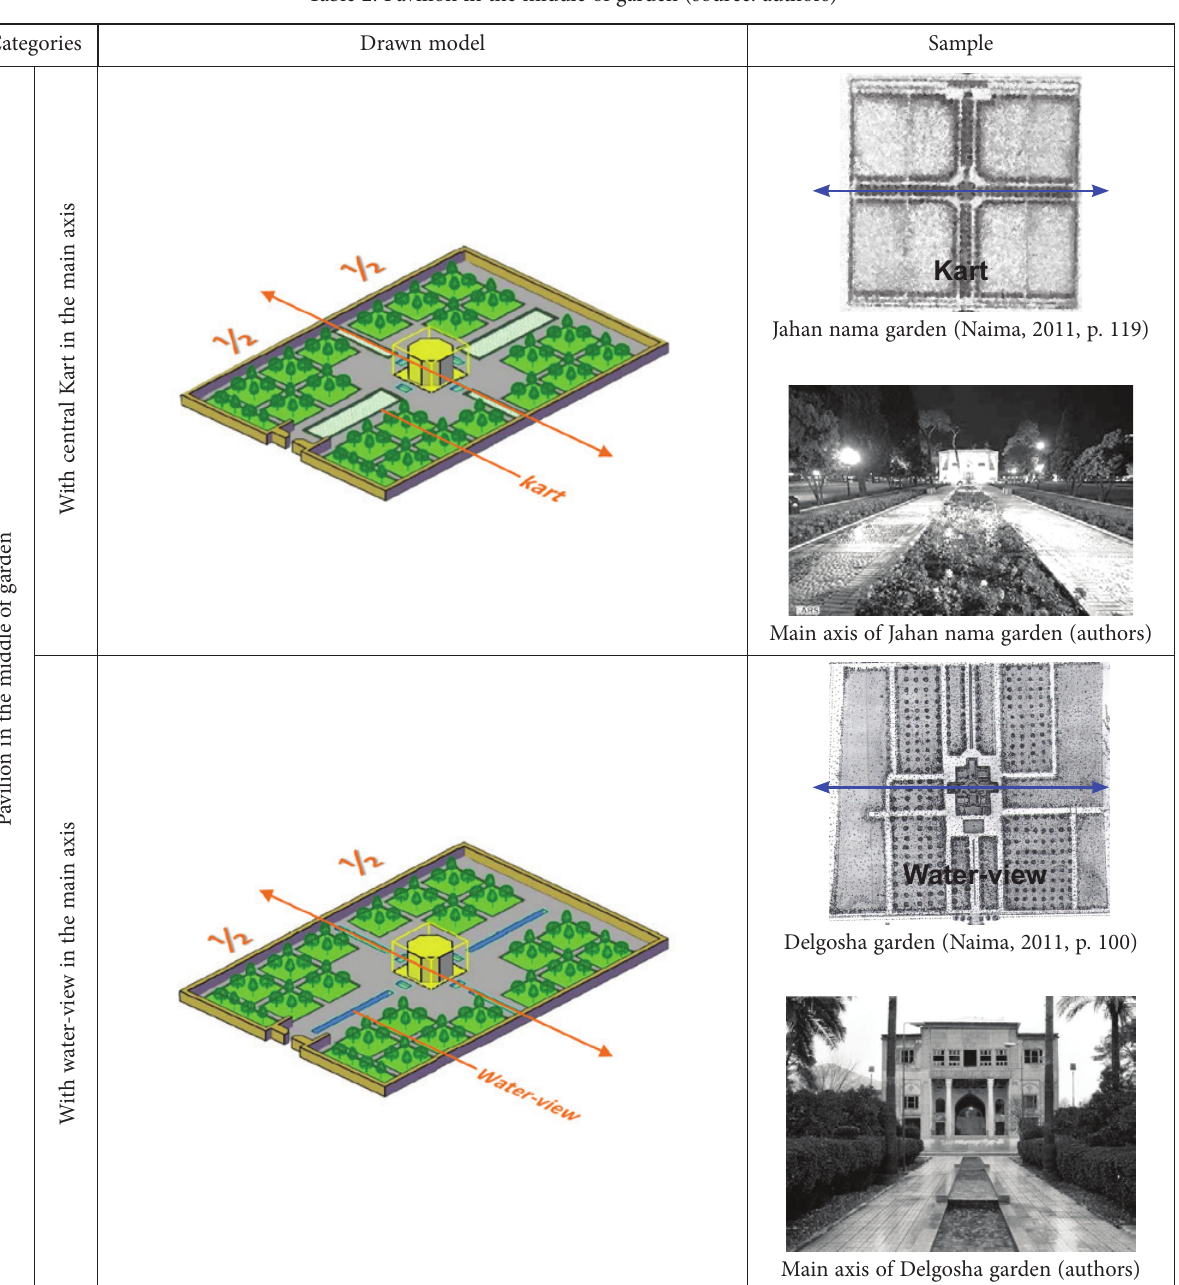
Table 2. Pavilion in the middle of garden (source: